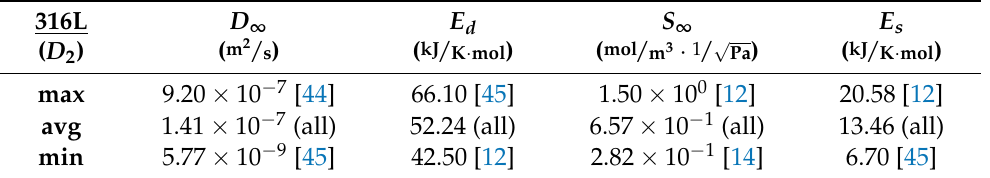
Table 1. Average and extreme values of dissolution parameters for deuterium dissolution in 316L steel, derived from literature and applied in the simulations [12,14,44,45].